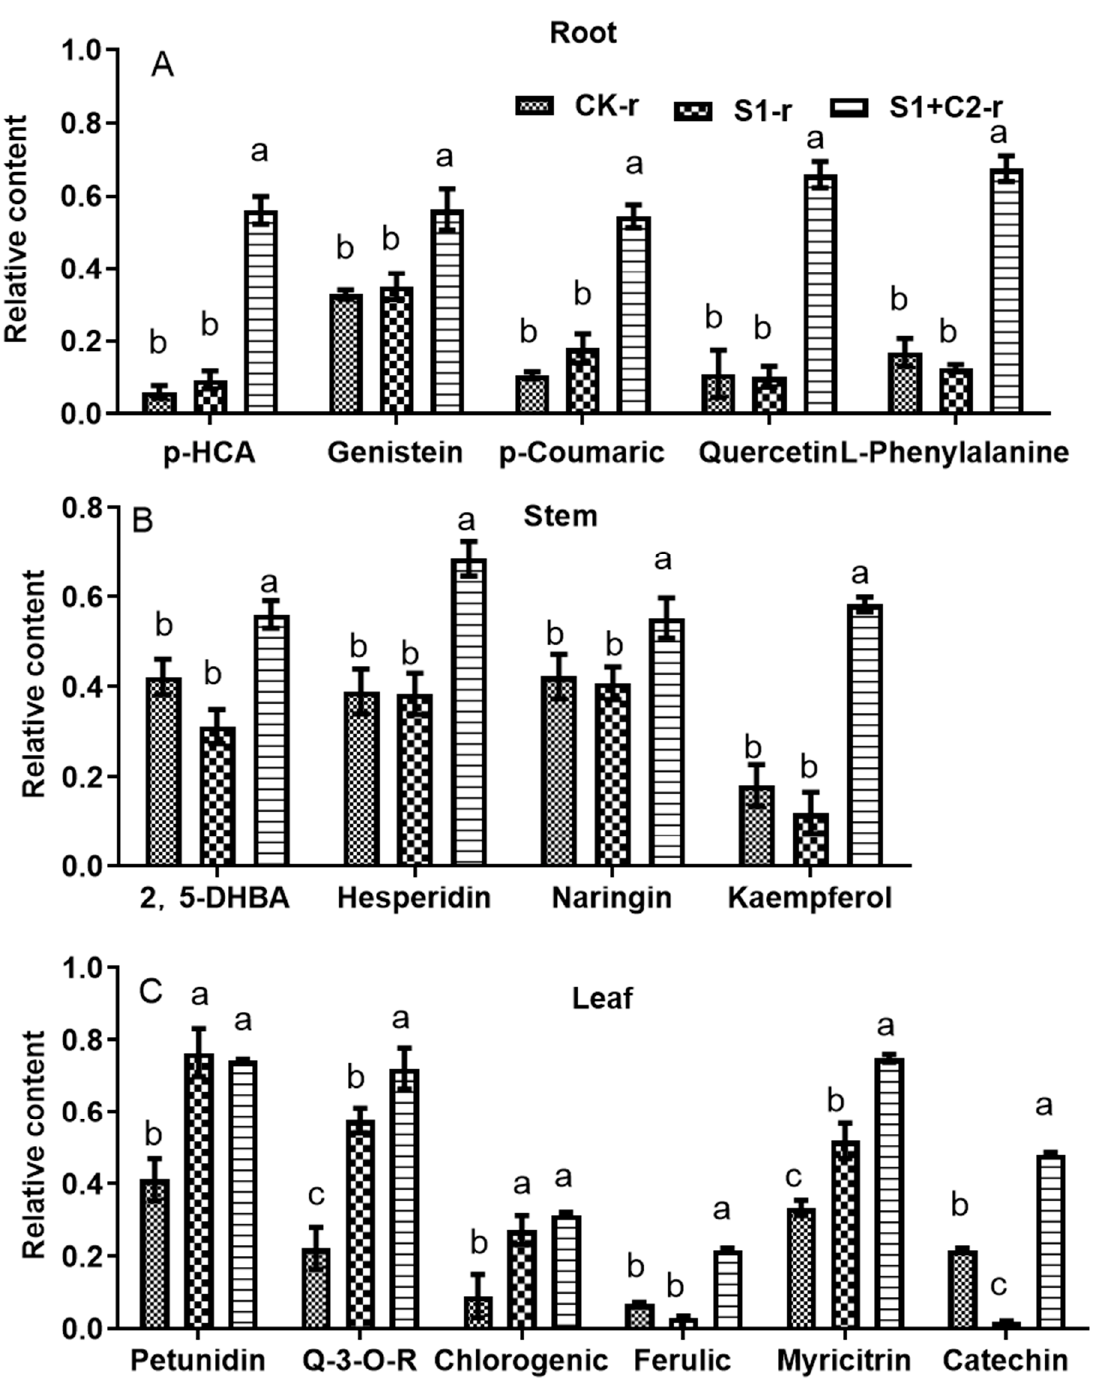
Figure 7. Response of the iconic phenolic compounds in G. sinensis to different treatments from root( A ), stem( B ) and leaf( C ), respectively. Normal hydroponic conditions (CK), 100 mmol/L NaCl treatment (S1), 100 mmol/L NaCl + 10 mmol/L CaCl 2 (S1 + C2); p-hydroxycinnamic acid (p-HCA), 2,5-dihydroxybenzoic acid (2,5-DHBA), quercetin-3-O-rhamnoside (Q-3-O-R). The data are the average SD of three independent replicates. The mean values represented by the different letters were significantly different in Tukey’s test at p < 0.05.